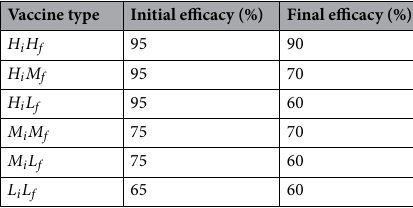
Table 1. Vaccine